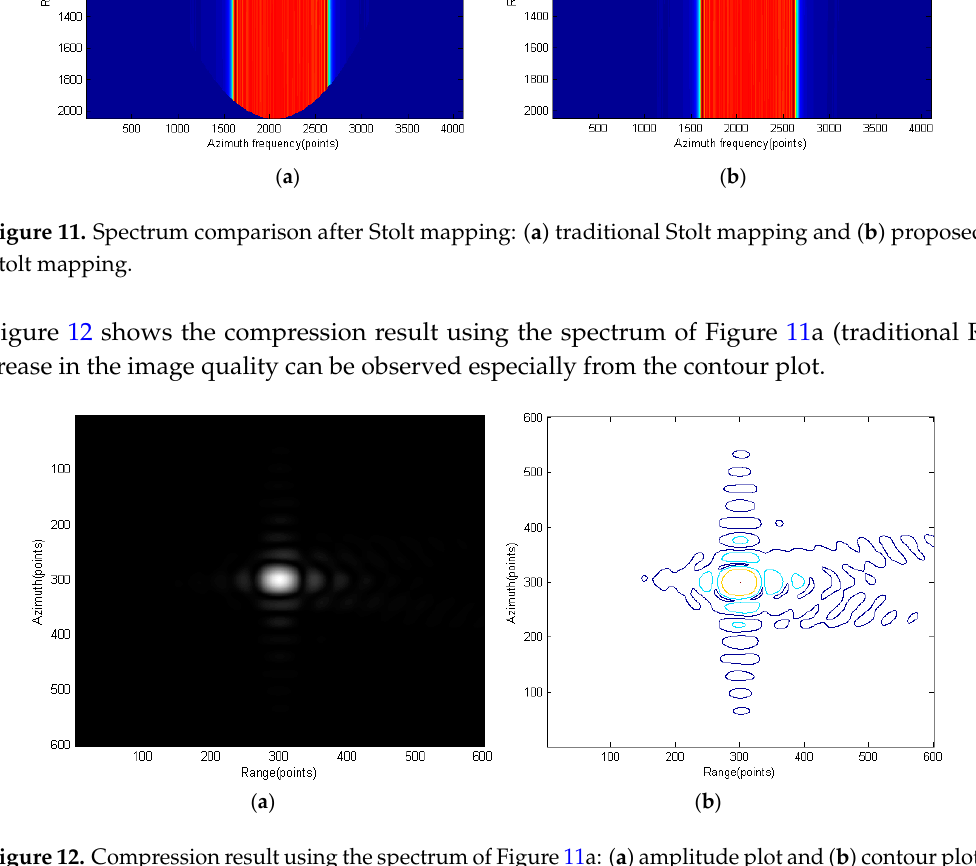
Figure 12. Compression result using the spectrum of Figure 11a: ( a ) amplitude plot and ( b ) contour plot.